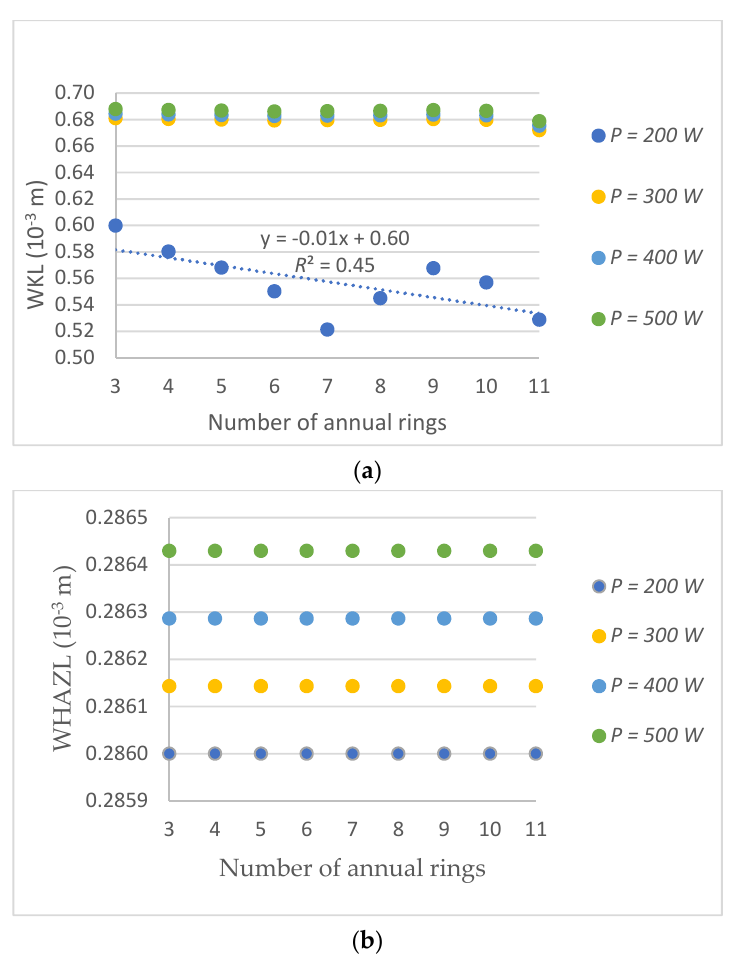
Figure 3. ( a ) WKL vs. AR, P at 1.2·10 − 2 m·s − 1 ; ( b ) WHAZL vs. AR, P at 1.2·10 − 2 m·s − 1 .